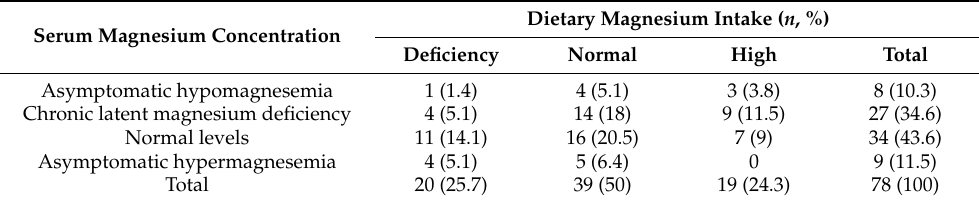
Table 2. Number and percentage of cases with deficient/adequate magnesium intake versus nor- mal/abnormal serum magnesium levels. ( n = 78).